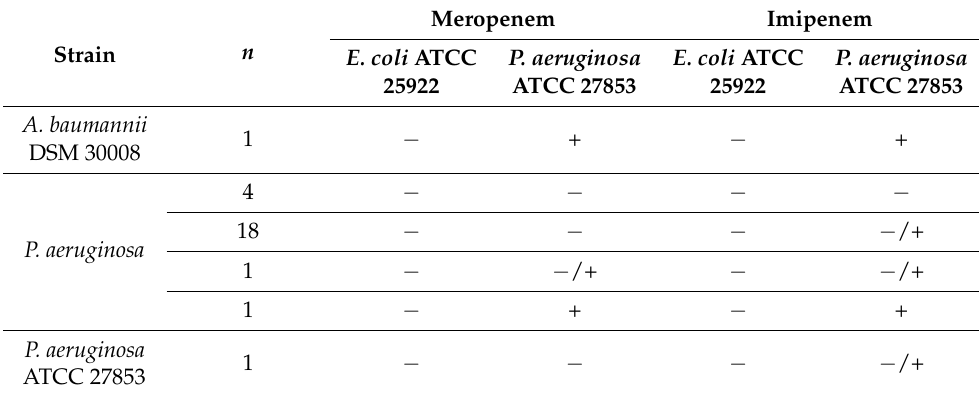
Table 2. CIM test results for the carbapenemases-negative strains ( n = 26).